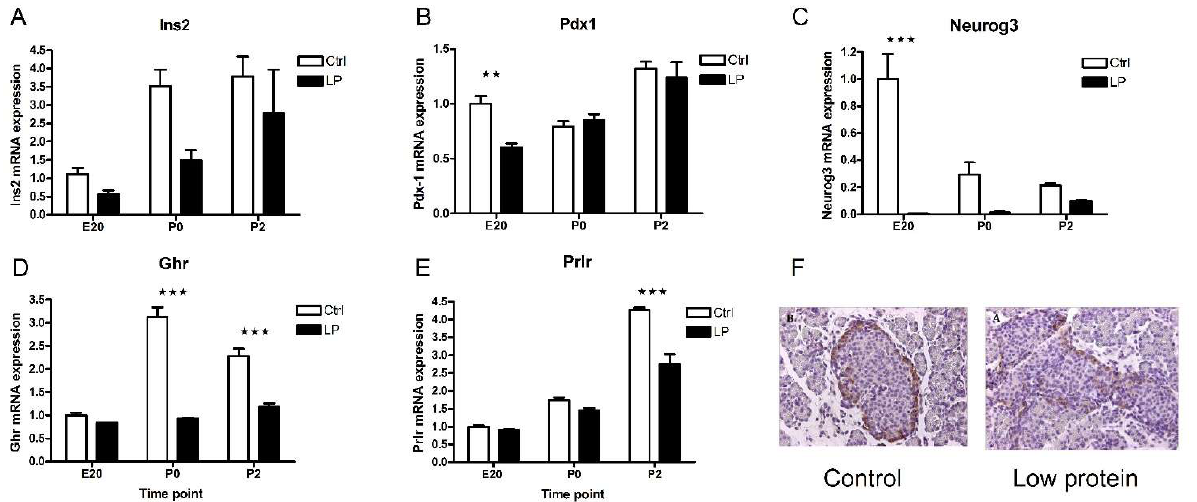
Figure 4. Relative Ins2, Pdx-1, Neurog3, Ghr, and Prlr mRNA expression in perinatal rat pancreas from control (Ctrl) and low-protein (LP) diet animals. Messenger RNA levels measured using RTqPCR in whole rat pancreas samples at days E20, P0, and P2. Values are normalized to levels at E20 within each data set, n = 3–6. Data are given as means + SEM. ( A ) Ins2 , ( B ) Pdx1 , ( C ) Neurog3 , ( D ) Ghr , ( E ) Prlr , and ( F ) immunohistochemical stainings for Neurog3 in the perinatal rat pancreas at P0 (200 × magnification). Data in panels ( A – E ) were tested using 2-way ANOVA with Bonferroni post tests for control vs. LP animals. Asterisks indicate significance levels of individual